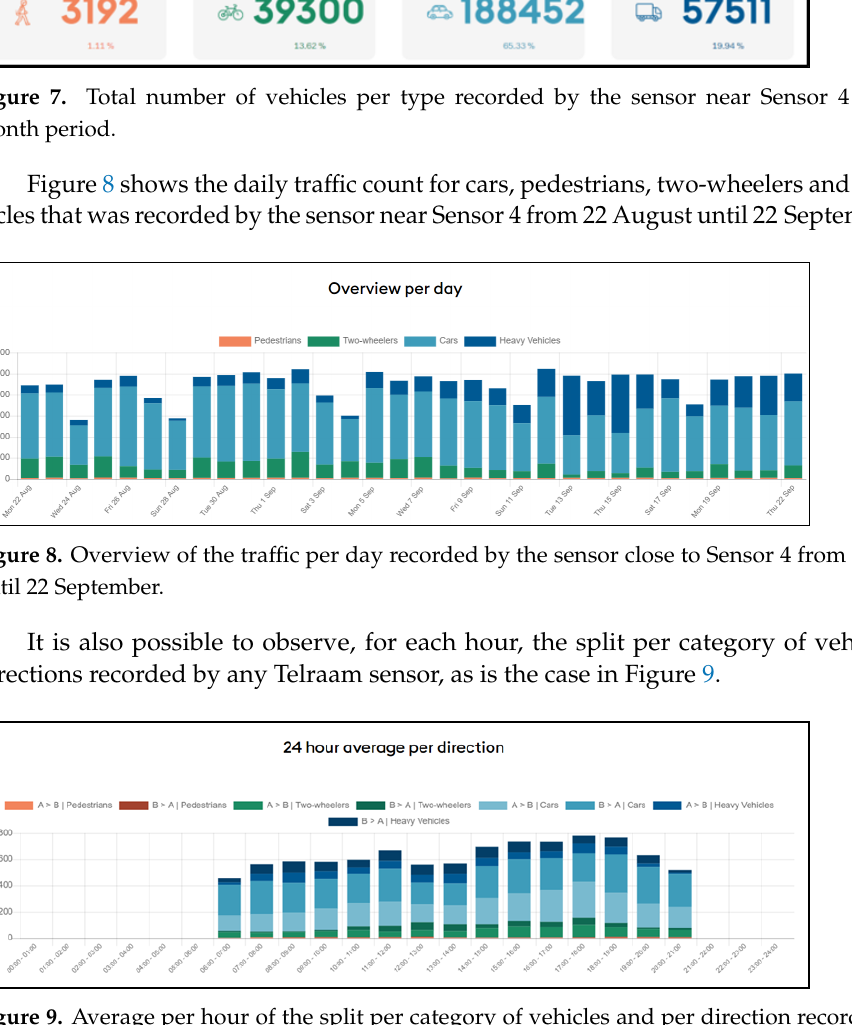
Figure 9. Average per hour of the split per category of vehicles and per direction recorded by the sensor close to Sensor 4 from 22 August until 22 September. A > B represents the direction from the left to the right, and B > A represents the opposite